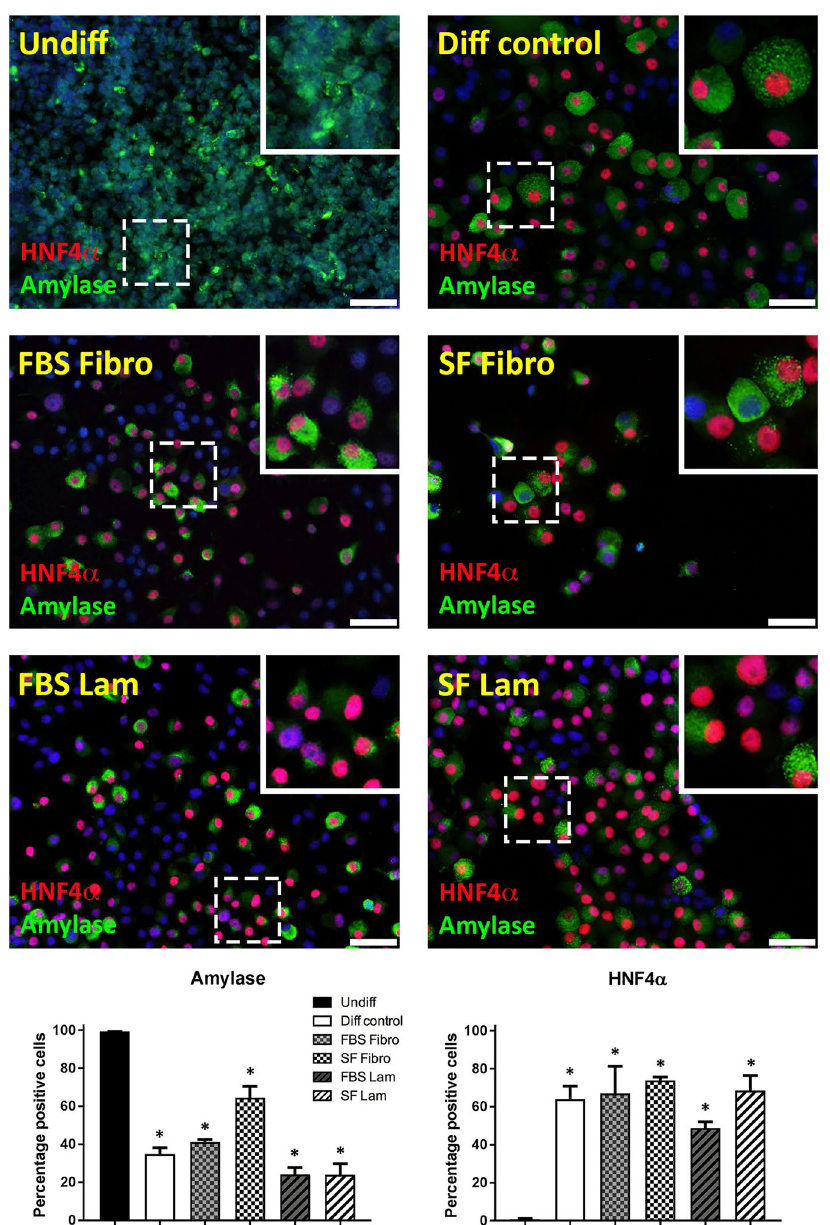
Figure 4. Immunofluorescent staining and quantification of pancreatic amylase (green) and hepatocyte nuclear factor 4 α (green) in undifferentiated AR42J-B13 cells and cells subjected to differentiation-inducing conditions on day 5, with DAPI (blue) for nuclear quantitation. Undiff - undifferentiated cells; Diff control - differentiation control, with FBS, on plastic; FBS Fibro - differentiation medium, with FBS, on fibronectin; SF Fibro - differentiation medium, serum-free, on fibronectin; FBS Lam - differentiation medium, with FBS, on laminin; SF Lam - differentiation medium, serum-free, on laminin. Scale bar = 50 µ